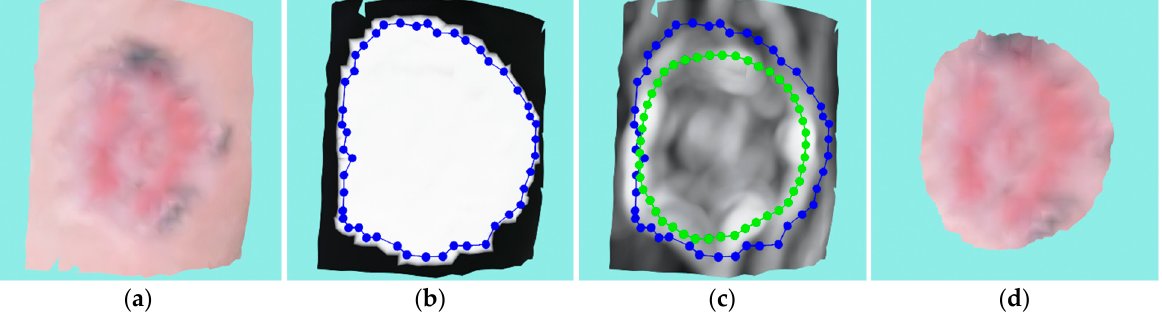
Figure 20. Case study for a larger venous ulcer: ( a ) input wound mesh; ( b ) masked wound mesh with initial contour; ( c ) wound mesh with curvature texture and initial and final contours shown in blue and green colors, respectively; ( d ) final cut wound mesh model.